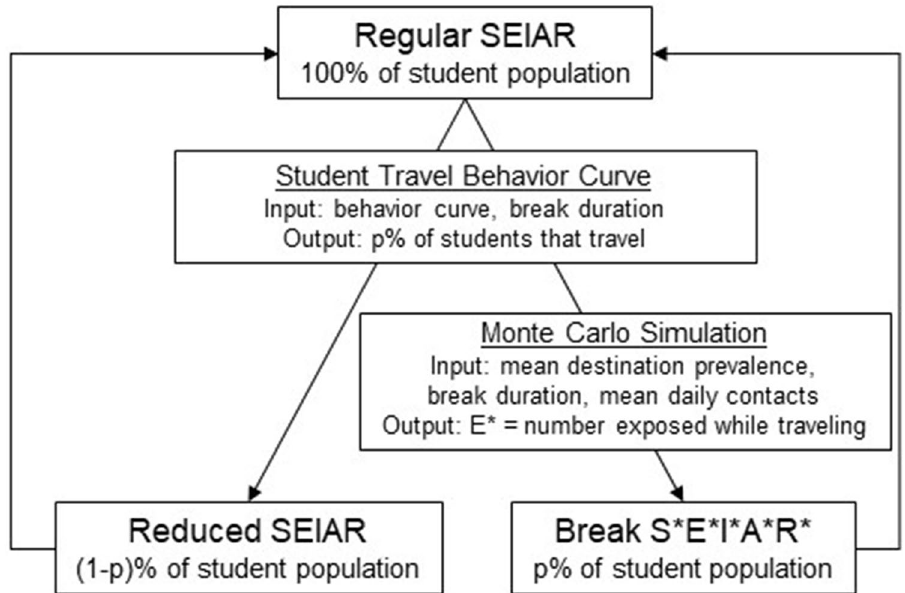
Figure 3. Computational model workflow. During regular-period, transmission dynamics at universities were simulated by a susceptible-exposed-infectious-asymptomatic-recovered model (Regular SEIAR). Student behavior scenarios determined how many students traveled (p%) given a specific number of days off. At the beginning of a break, traveling students left the Regular SEIAR compartments and followed the Break S*E*I*A*R* model, where Monte Carlo simulations determined the number of traveling students infected under a mean destination prevalence and mean daily contact scenario. During break-period, students [(1 − p)%] who did not travel followed SEIAR model (Reduced SEIAR). At the end of the break, traveling students return to the Regular SEIAR compartments until the next scheduled break or the end of the